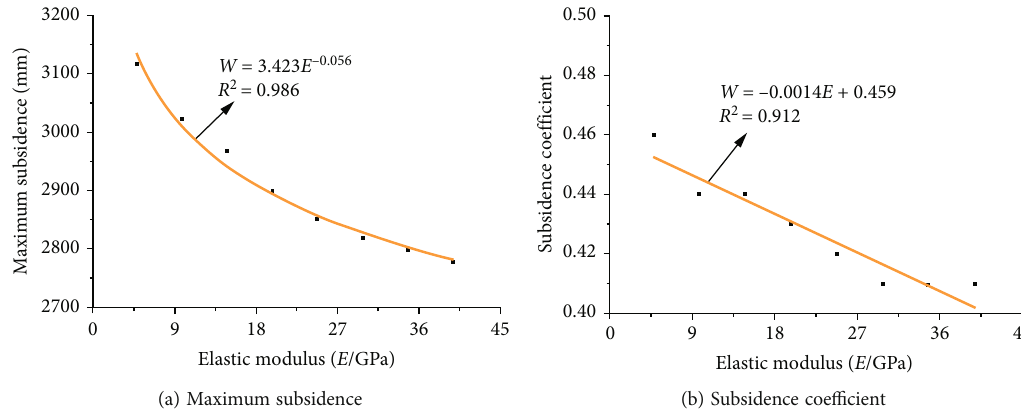
Figure 13: Fitting curve of maximum subsidence/subsidence coe ffi cient and elastic